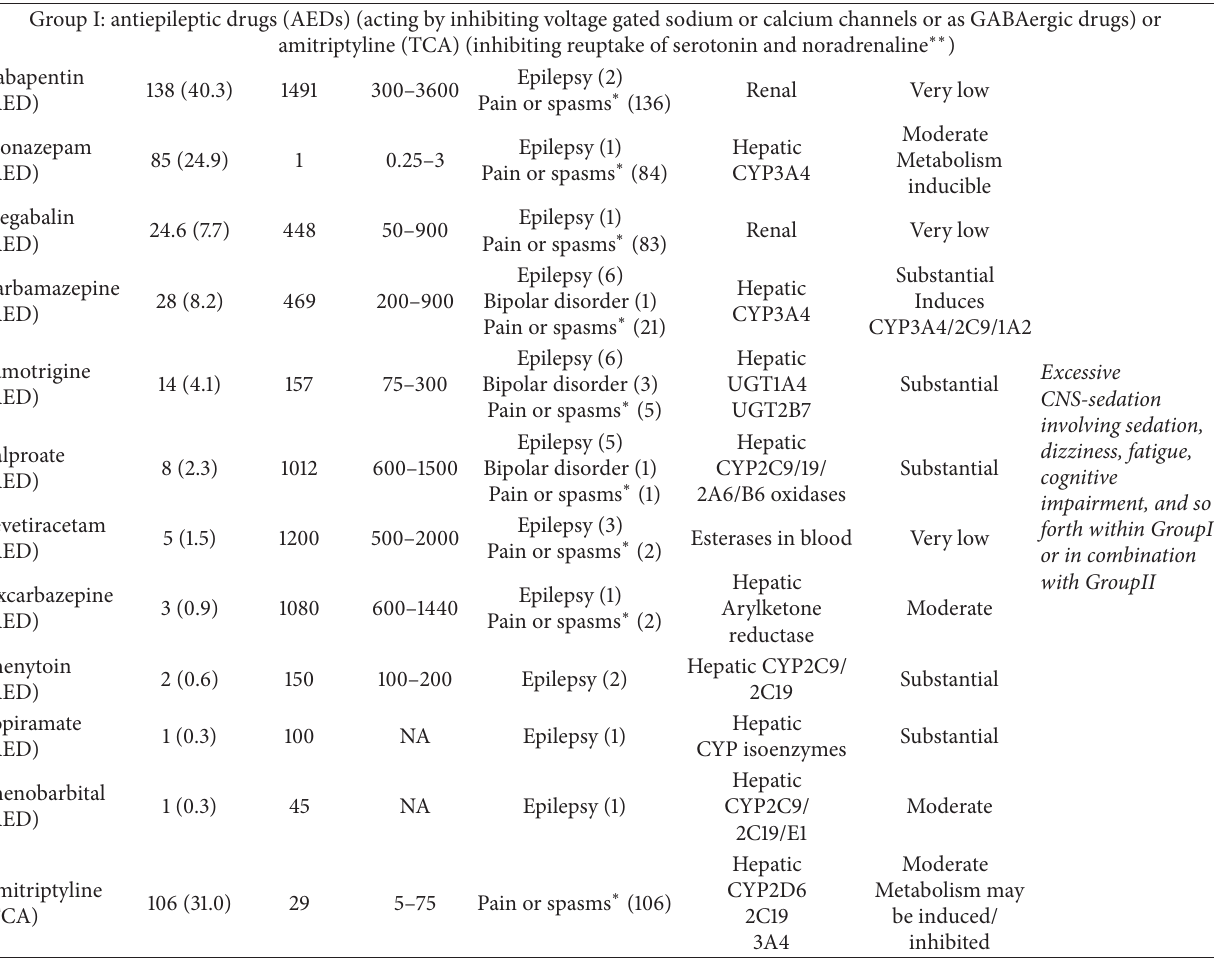
Possible Route of Propensity to pharmacodynamic elimination interact